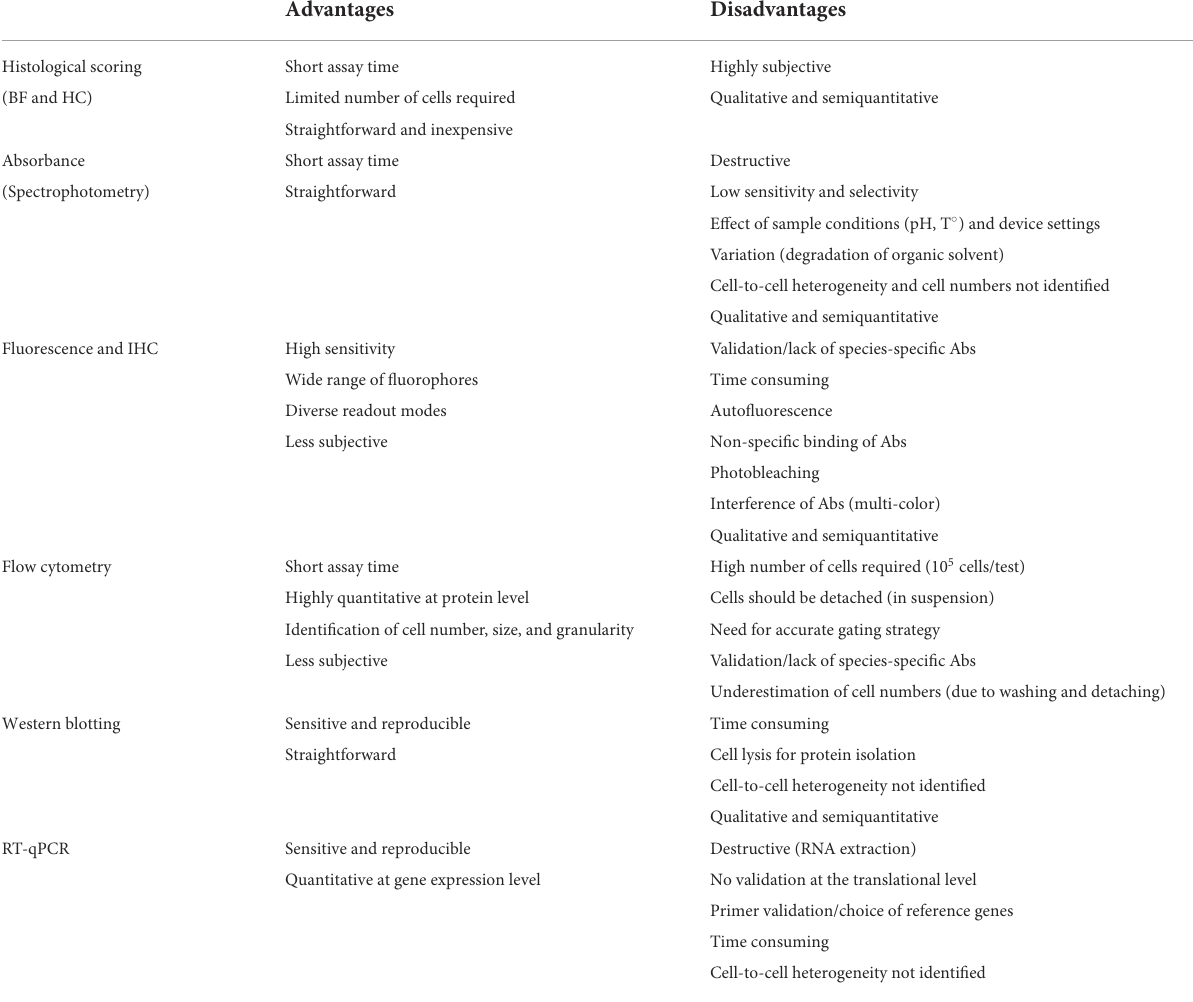
TABLE 1 An overview of the advantages and disadvantages of techniques mostly used for quantification of MSC tri-lineage